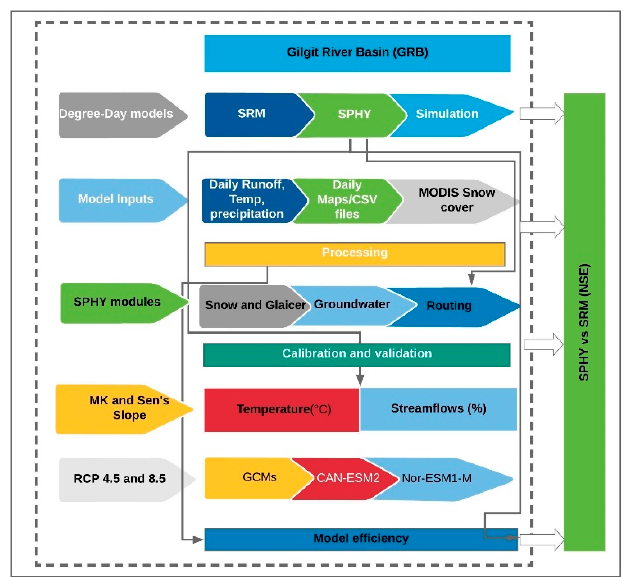
Figure 2. Methods and basic inputs for Snowmelt Runoff Model (SRM) and Spatial Processes in Hydrology (SPHY). Table 2. Characteristics of 7 altitudinal zones of Gilgit River Basin (GRB).